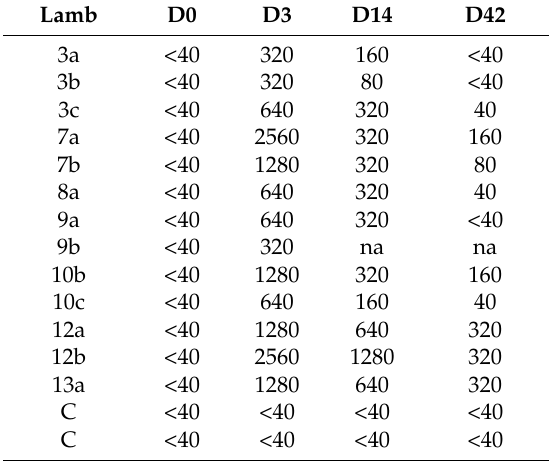
Table 4. Reciprocal indirect immunofluorescence antibody assay titres for A. phagocytophilum of 15 newborn lambs from birth (D0 before colostral intake) to day 42 (D42). A titre lower than 40 was considered negative (a, b, c indicate siblings; C = control lamb; na = not